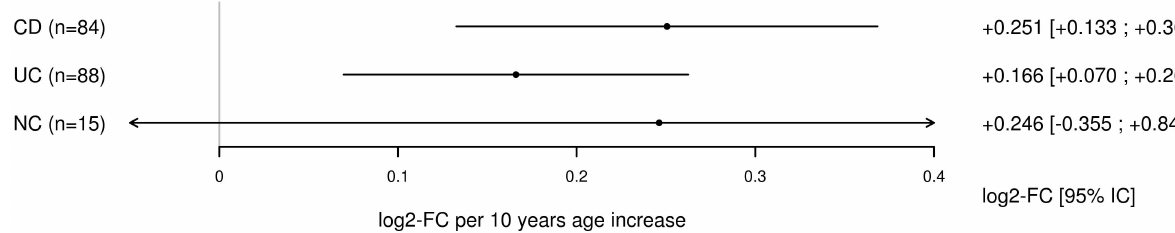
Fig 3. Variation of APOE levels with aging in CD, UC and NC subjects. Forest plot of the estimated log2-FC of APOE protein levels (probe SL000276)per 10 years increase in age, with 95% confidenceintervals, as obtainedfrom the differentialexpressionanalysis performed separatelyin Crohn’s Disease(CD), UlcerativeColitis (UC) and Normal Controls (NC) subjects. Estimated log2-FCs and 95% Confidence Intervals are further reportedon the